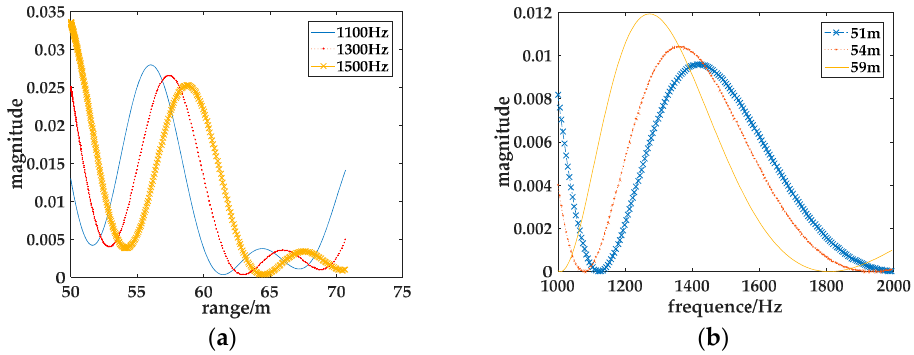
Figure 10. The sound field intensity variation: ( a ) the variations at different distances; ( b ) the variations at different frequencies.